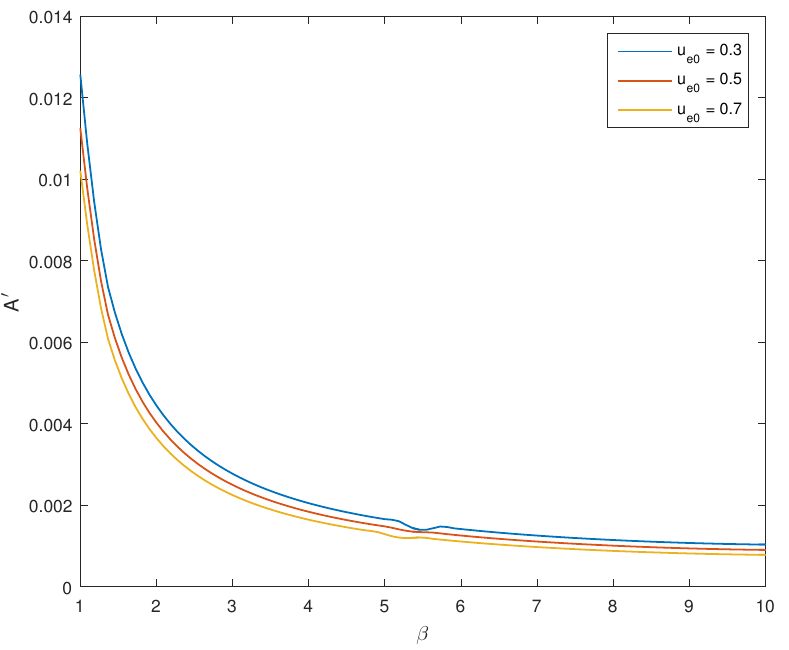
Figure 14. The variation of the nonlinear coefficient ( A (cid:48) ) in the case of a modified KdV equation with β (= n i 0 / ( Z d n d 0 ))